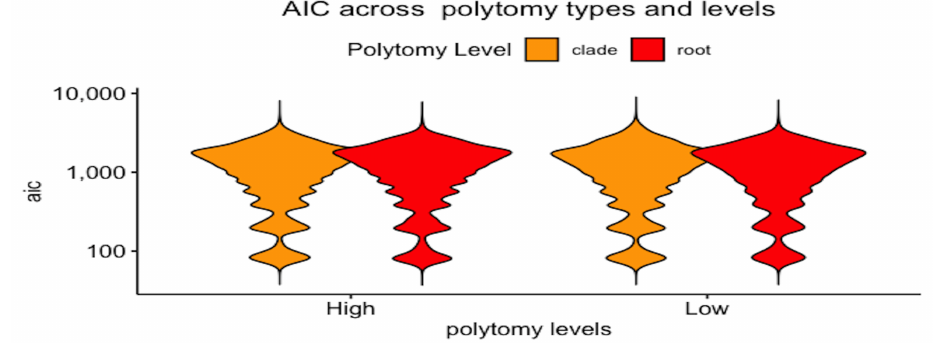
Figure 9. Violin plots of AIC by polytomy type and level, conditioned through taxa size, tree type, and model.